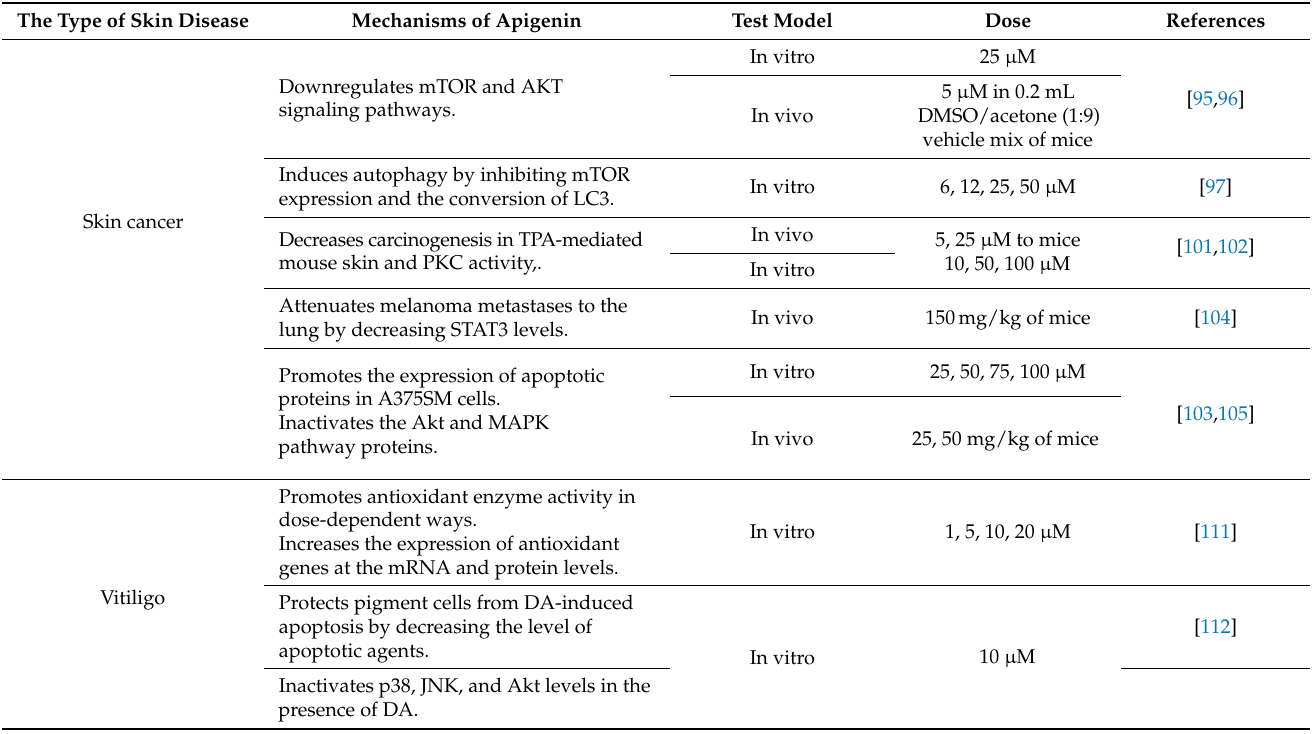
figure for the paper; J.H.Y., M.-Y.K. and J.Y.C. wrote the manuscript; M.-Y.K. and J.Y.C.